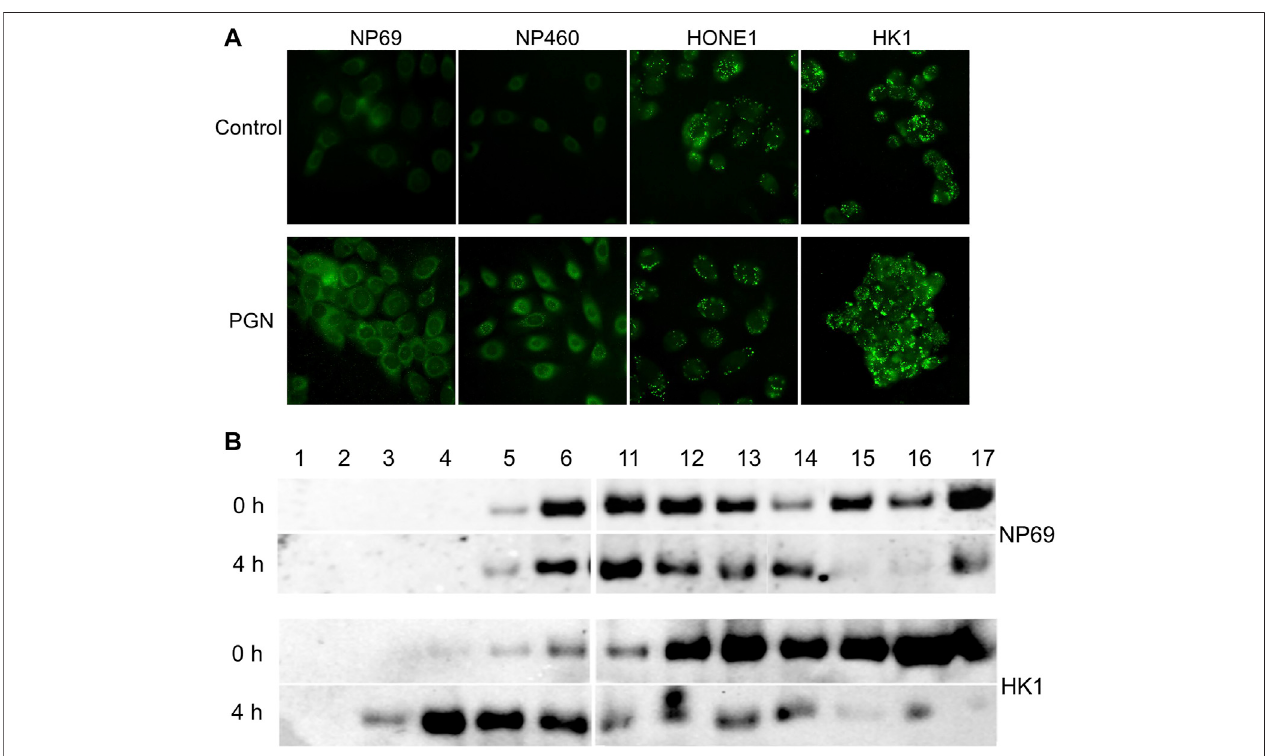
FIGURE 4| Lipid droplet (LD) accumulate in NPC cells. NF- κ B is associated with LDs in NPC cells. (A) Immuno fl uorescent analysisof lipid content in NPE cell lines (NP69 and NP460) and NPC cell lines (HONE1 and HK1) USING a lipid-speci fi c fl uorescent dye BODIPY 493/503. (B) Cells were treated with 10µg/mL of PGN for 2 hours, the media was changed, and the cells were harvested at 0 and 4 h time points. The HK1 versus NP69 cells were fractionated on a discontinuous density gradient to separate lipid-containing fractions. Fractions were analyzed using Western blot for the expression of NF- κ B (p65).